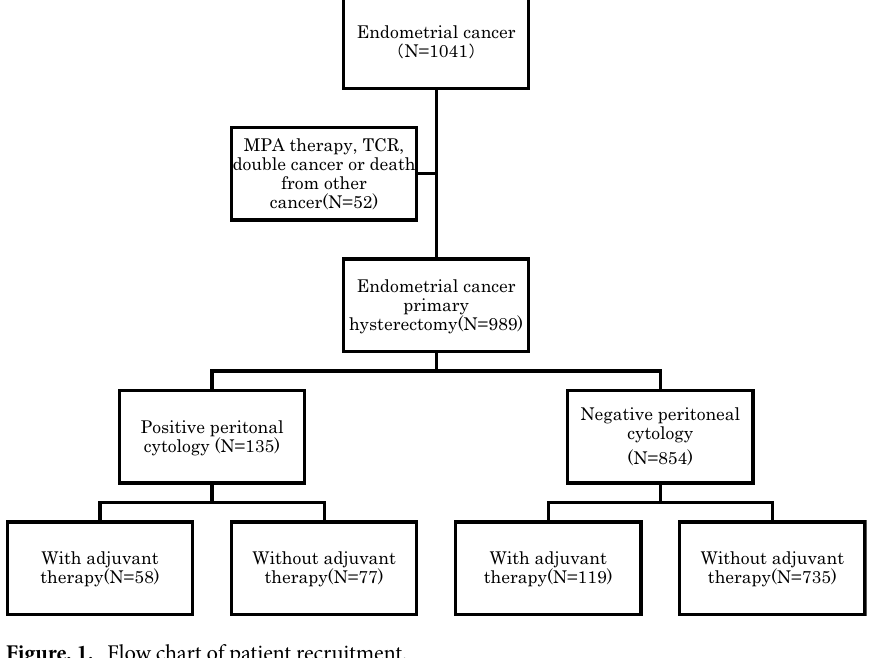
Figure. 1. Flow chart of patient